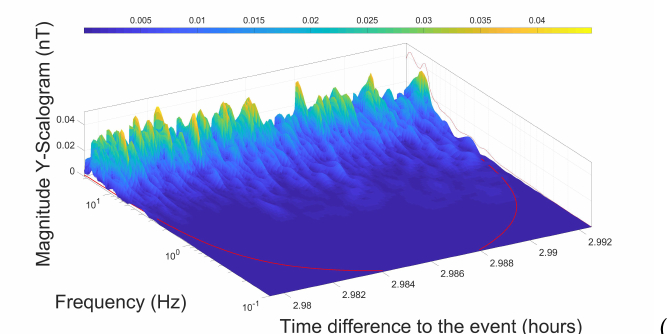
Figure 1. ( a ): Magnetic field variation ∆ B z (nT) time series from Swarm A VFM (50 Hz) and scalogram for a post-crossing with a time lag of +3 h of the 28 August 2014 volcanic eruption event (Holuhraun 1), Bárðarbunga, Iceland. The so-called ”cone of influence” (red line in the spectra) divides the wavelet spectrum in two parts, in the inner (large) area edge effects according to the chosen parameters are negligible. ( b ): Coarse map of Iceland with the illustration of the Bárðarbunga volcano (yellow star), the Holuhraun lava field (yellow diamond), and the footprints of Swarm A (7 traces, red colour), Swarm B (4 traces, black), and Swarm C (5 traces, white) for the investigated eruption time span 28 August 2014 ± 10 days within the spatial domain given in a box size (footprint area) of ± 1.5 deg in latitude and longitude centred around Bárðarbunga. The ingress points are marked with larger symbols, i.e., north-south crossings or vice versa are readily identifiable. ( c ): Oblique view of a Swarm A VFM single trace scalogram based on ∆ B x (nT) time series variations with noticeable fluctuations (after wavelet analysis) in the higher frequency range (smaller scales), i.e., attenuations and enhancements of magnetic field fluctuations possibly given by AGW interaction with the F-region plasma. ( d ): like in (c), 3D scalogram view for the ∆ B y (nT)